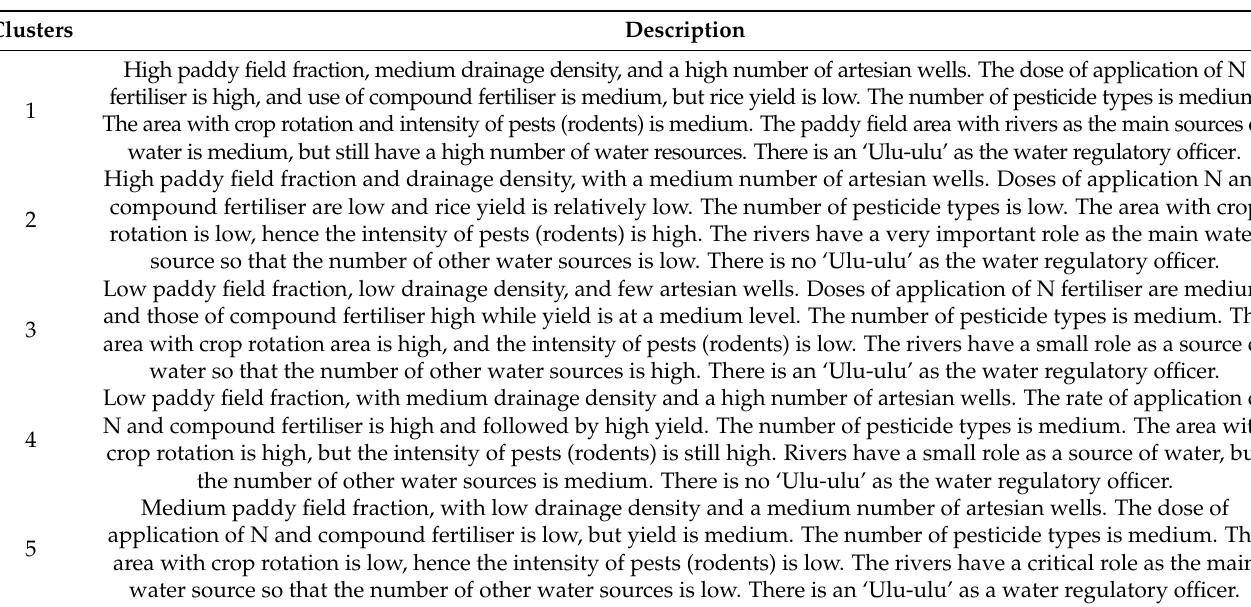
Table 7. Description of each paddy field